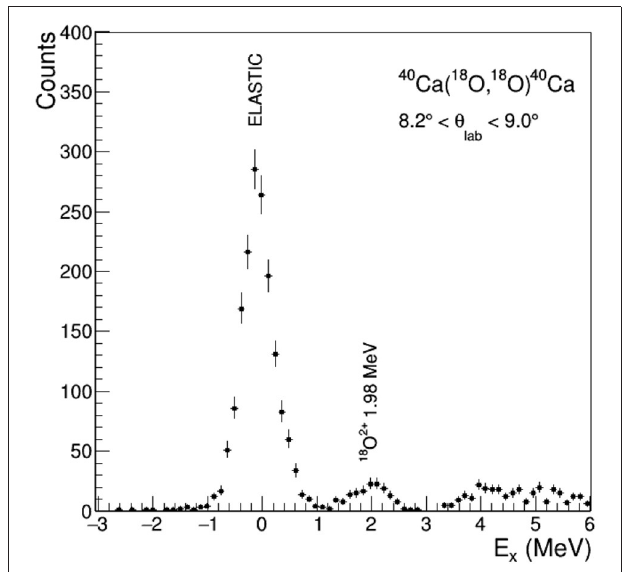
FIGURE 1 | Excitation energy spectrum of 40 Ca obtained in the 18 O elastic scattering and inelastic scattering at an incident energy of 275 MeV and 8.2 ◦ < θ lab < 9.0 ◦ .